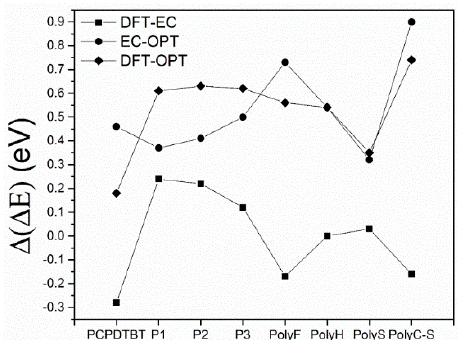
Figure 6. Discrepancies between band gaps computed by means of DFT method and electrochemically determined; band gaps electrochemically and spectroscopically determined; band gaps computed by means of DFT method and spectroscopically determined.